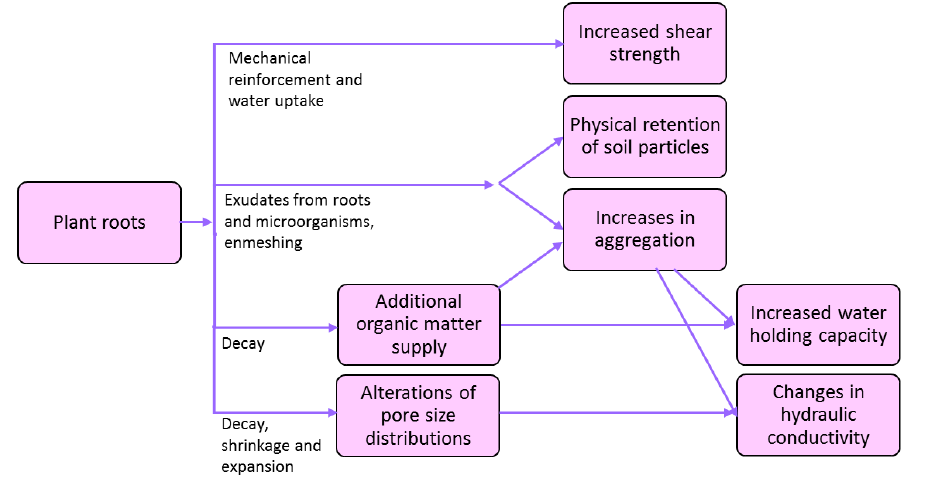
Figure 1. Key mechanisms by which plant roots influence soil physical properties.